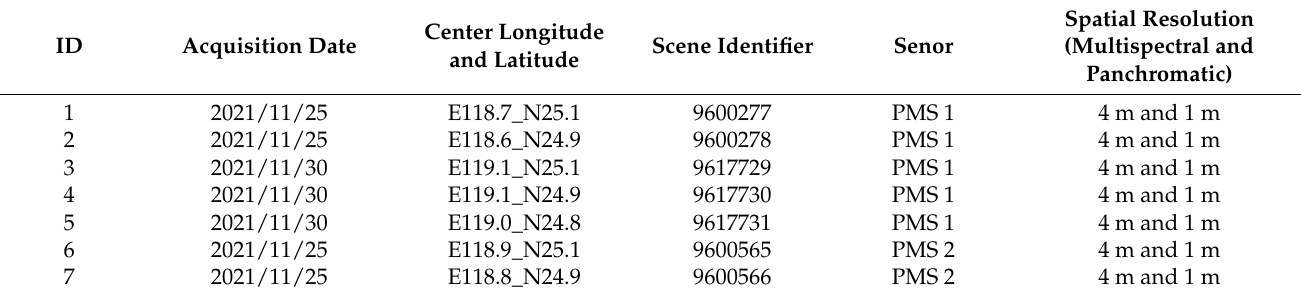
Table 1. GF-2 image band